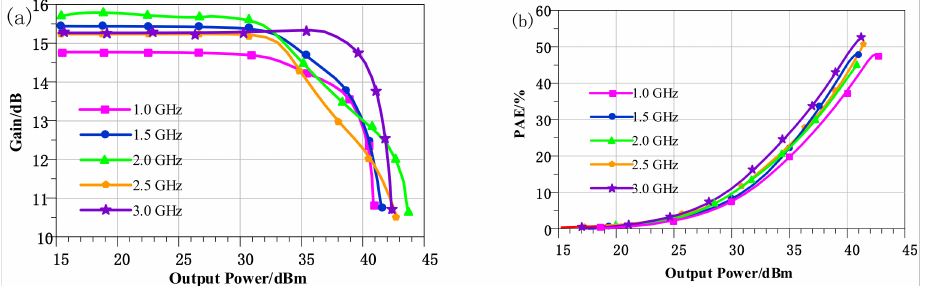
Figure 13. HB-balance simulation results of the proposed PA. ( a ) Output power & Gain; ( b ) Output power & PAE.